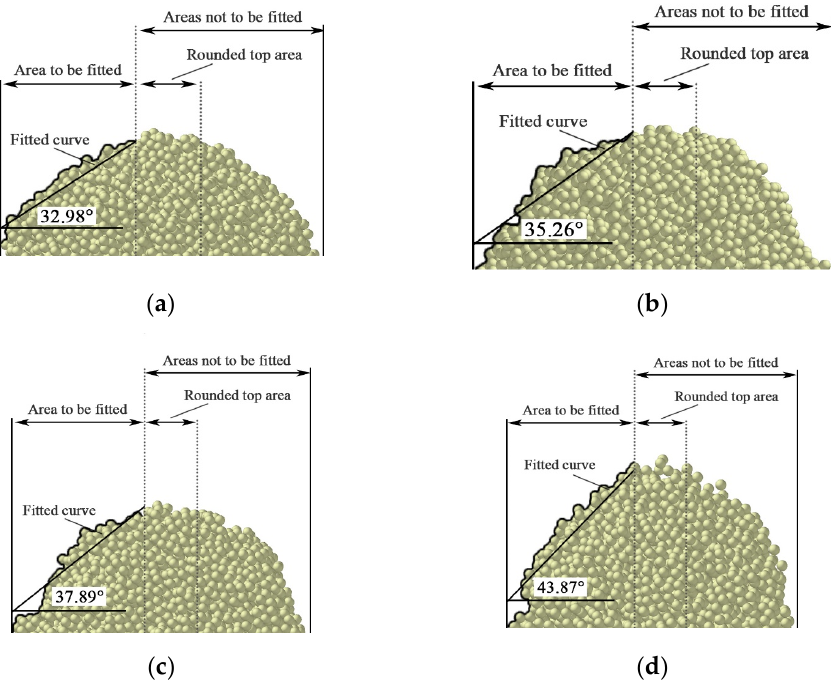
Figure 9. Simulation of the rest angle of soil with ( a ) 3%, ( b ) 6%, ( c ) 9%, and ( d ) 12% water